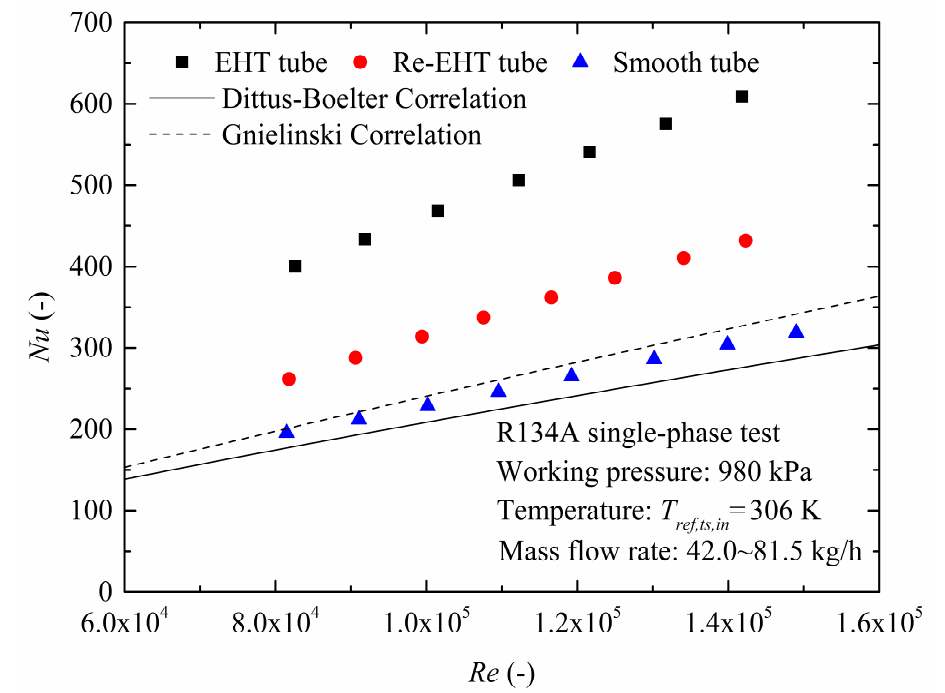
Figure 5. Variation of Nusselt number with Reynolds number for single-phase heat transfer in two enhanced tubes and one smooth tube.